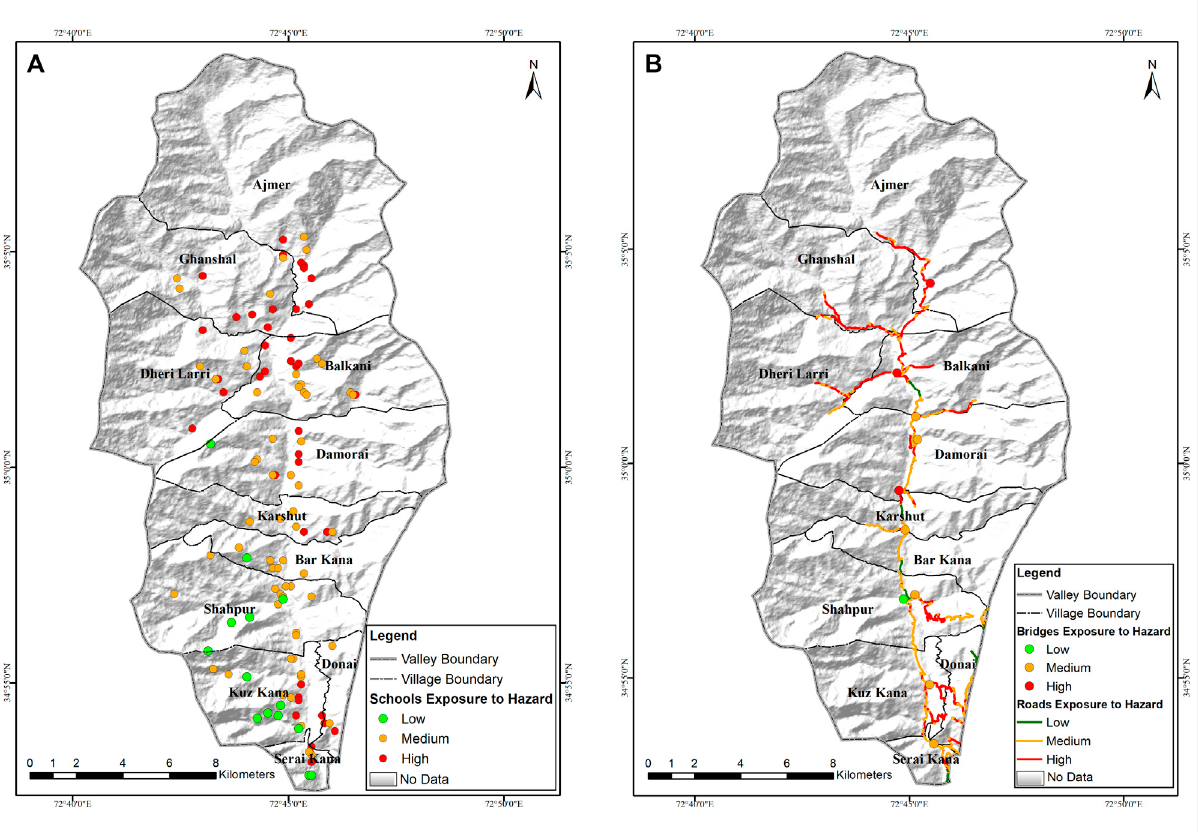
FIGURE 10 Shahpur valley. (A) School exposure to the likelihood of landslide occurrence. (B) Roads and bridge exposure to the likelihood of landslide